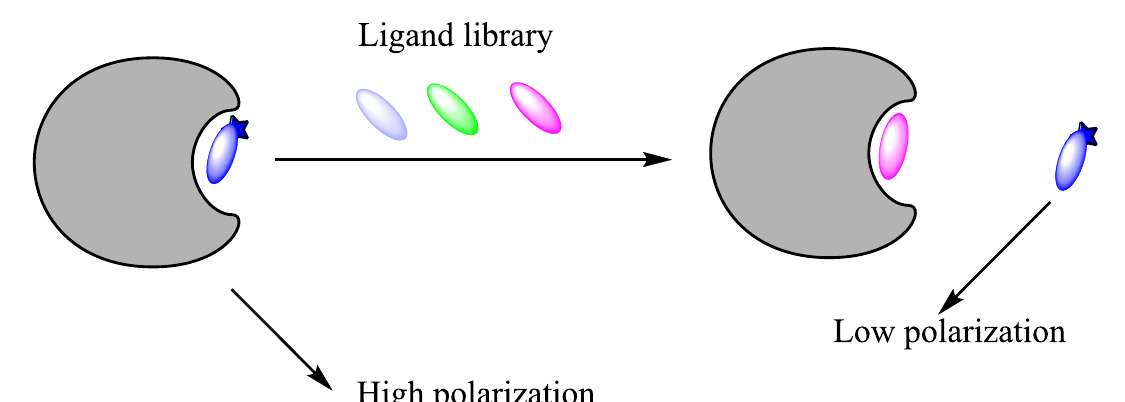
Figure 14. A schematic presentation of a fluorescence polarization displacement assay. First, the enzyme and the fluorescent probe are mixed in a solution: the probe binds to the active site of protein, forming a complex that will give a high polarization; competitive inhibitor/ligand will displace the probe and release it into the bulk phase that will result in decrease of light polarisation.